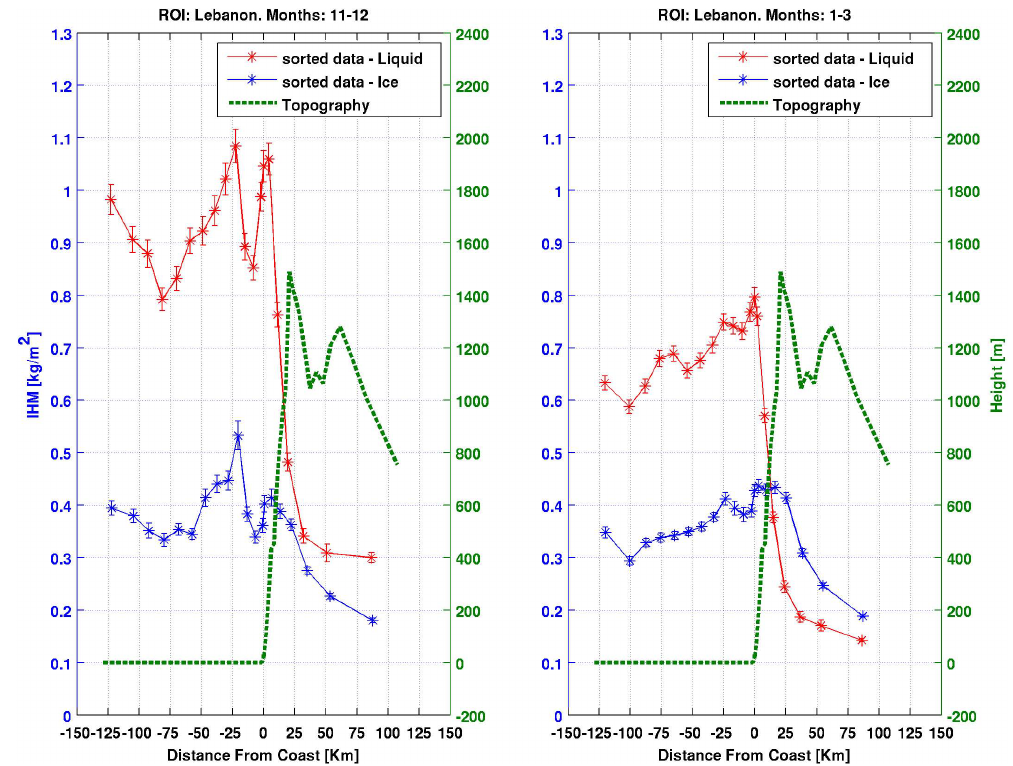
Fig. 9. Same as Fig. 6, but for “Lebanon” sub-region. The two ridges reach their highest elevations at 21km and 60km inland. The November–December, January–March counts per bin are 3743, 6754 for liquid IHM and 3507, 6719 for ice IHM,